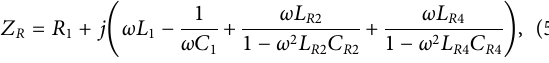
Z → Z θ (cid:1) π /2 + k π . With all of these impedance R 0 and 0